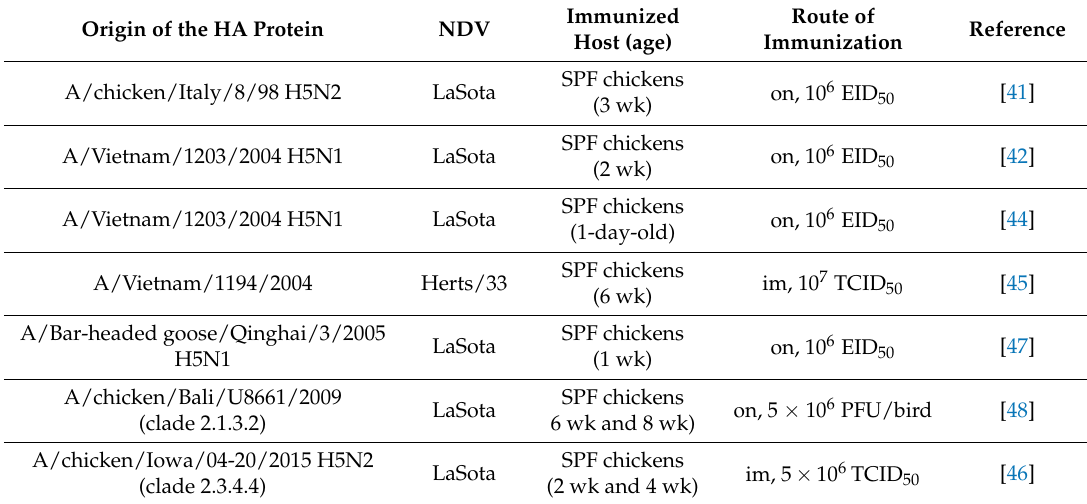
Table 1. Newcastle disease virus (NDV)-vectored vaccines against H5 serotypes. Origin of the HA